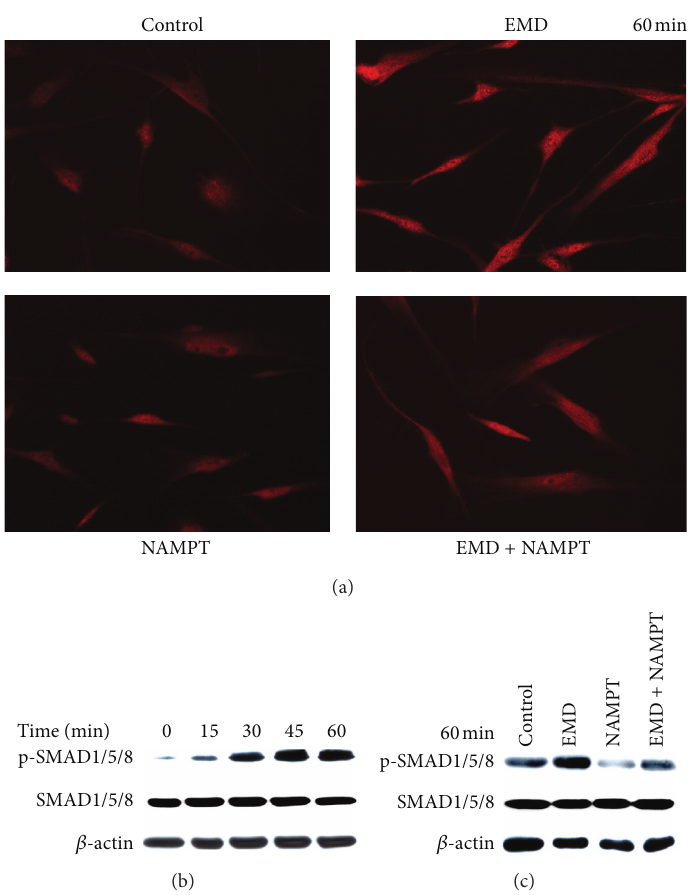
Figure 5: Effect of EMD on the nuclear translocation of SMAD1/5/8 in the presence and absence of NAMPT (100ng/mL) at 60 min, as determined by immunofluorescence (a). Untreated cells served as control. Stimulation of SMAD1/5/8 phosphorylation by EMD over 60min, as analyzed by immunoblotting (b). Effect of EMD on SMAD1/5/8 phosphorylation in the presence and absence of NAMPT (100ng/mL) at 60min, as examined by immunoblotting (c). All experiments were performed in triplicate and repeated at least twice. Images and blots from one representative donor are